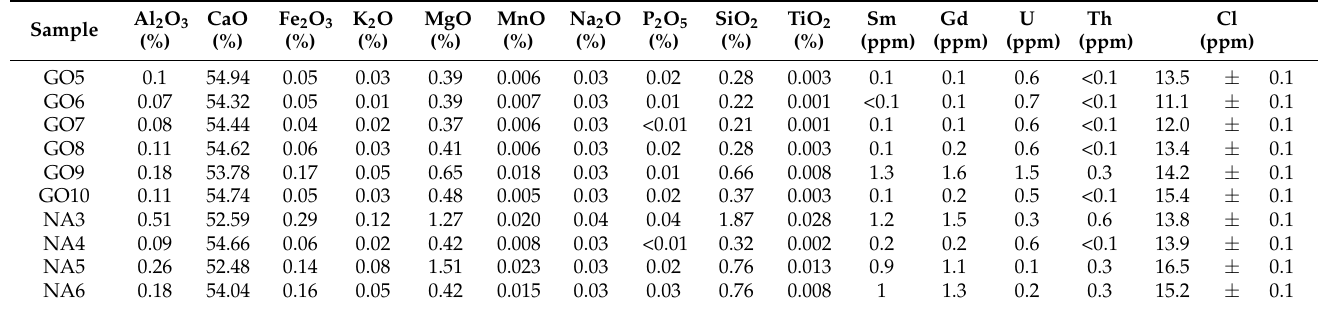
Table 2. Elemental composition of leached samples. Cl values are from AMS measurements.